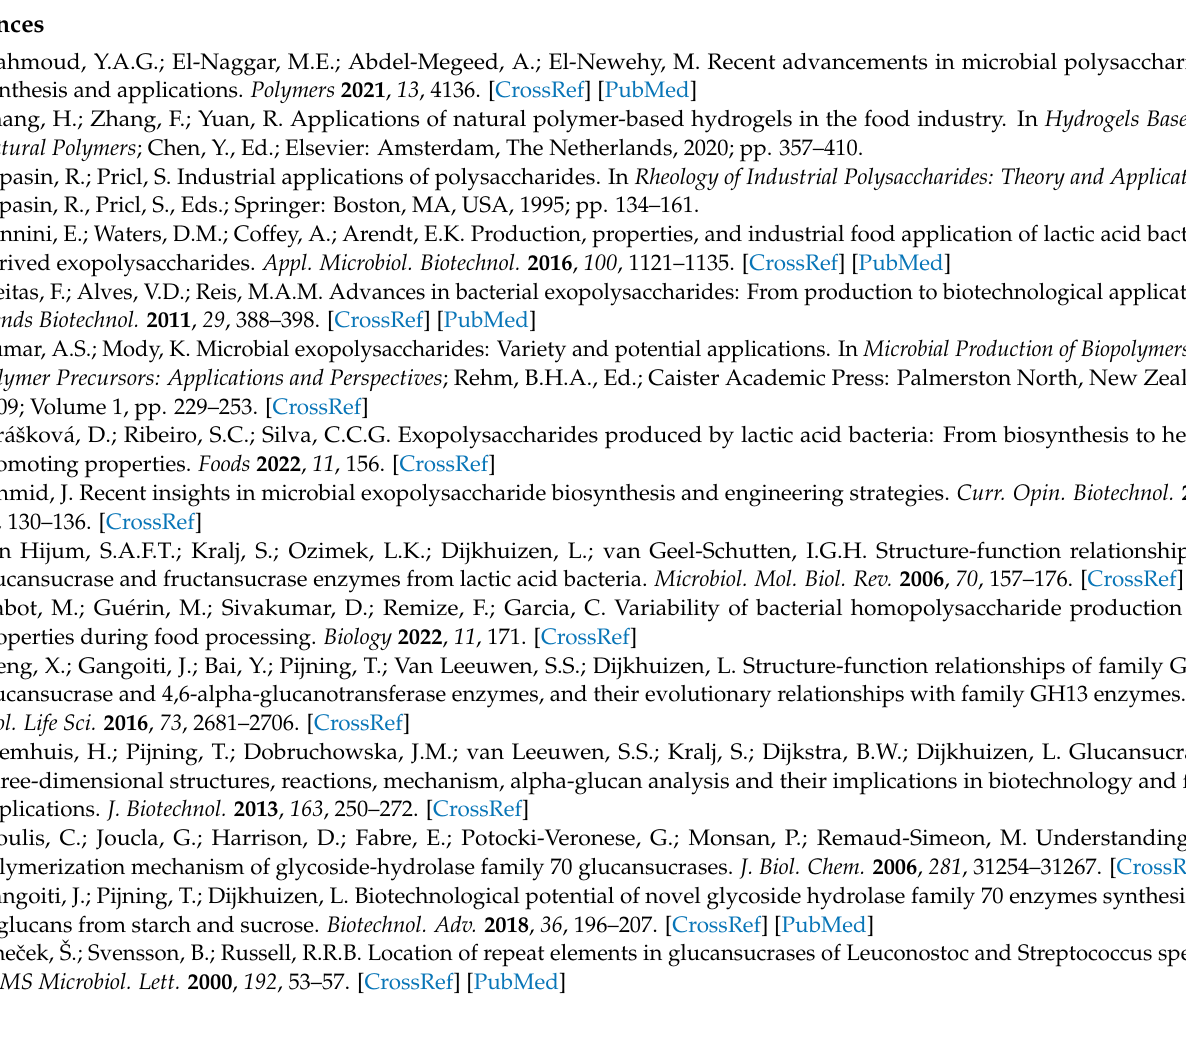
Table S2: Primers used for the cloning and sequencing of the two dextransucrase variants dsr3510 and dsr3510 ∆